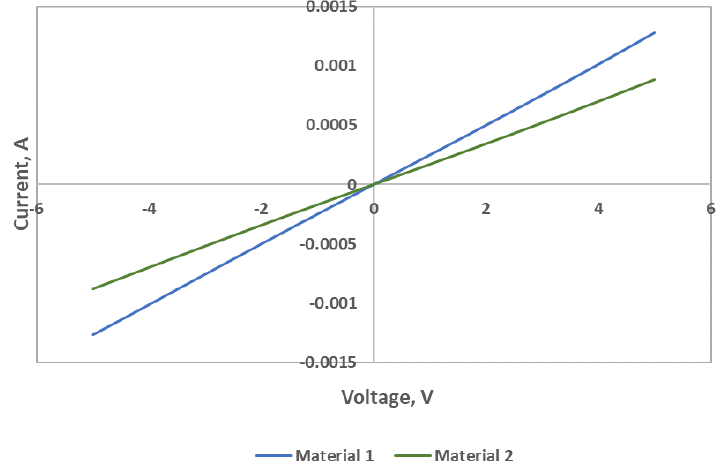
Figure 3. I-V characteristics of the sensing materials: Material 1 and Material 2.